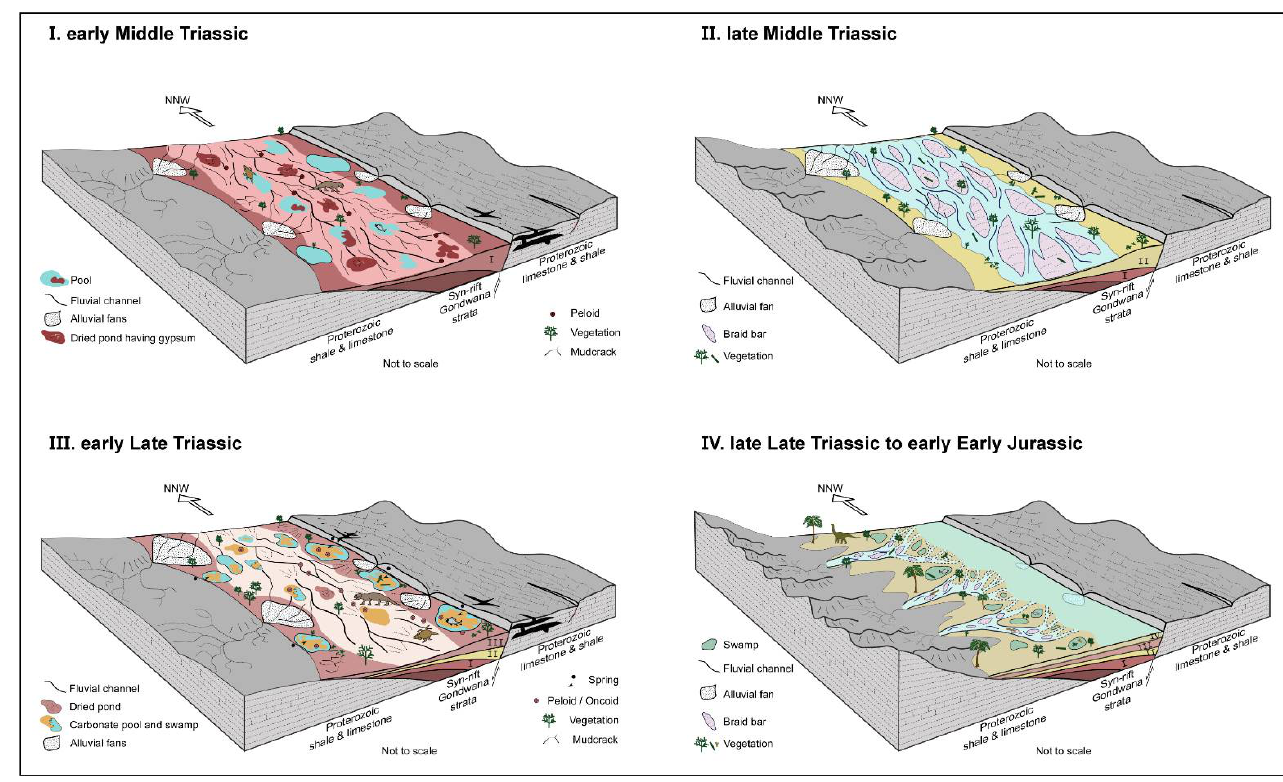
Figure 12. Schematic block diagrams representing the organization of the palaeoenvironments in the Pranhita-Godavari Gondwana rift-basin flanked by Proterozoic sedimentary rocks is shown. ( I ) shows the spatial relationship among different types of lithology during the early Middle Triassic, when fine sediments of the Yerrapalli formation were deposited; ( II ) shows the scenario of the late Middle Triassic, when essentially sandstone deposition took place during the sedimentation process of the Bhimaram formation; ( III ) shows the setting of the early Late Triassic sediments of the Maleri formation [40,52]; ( IV ) shows the scenario of the late latest part of the Triassic to early Early Jurassic when the coarse sediments of the Dharmaram formation were deposited in a transverse system, unlike in the previous stages, during which sediments were deposited in the axial drainage system. Lower Kota formation [82,83], the h545details of which are not the focus of this